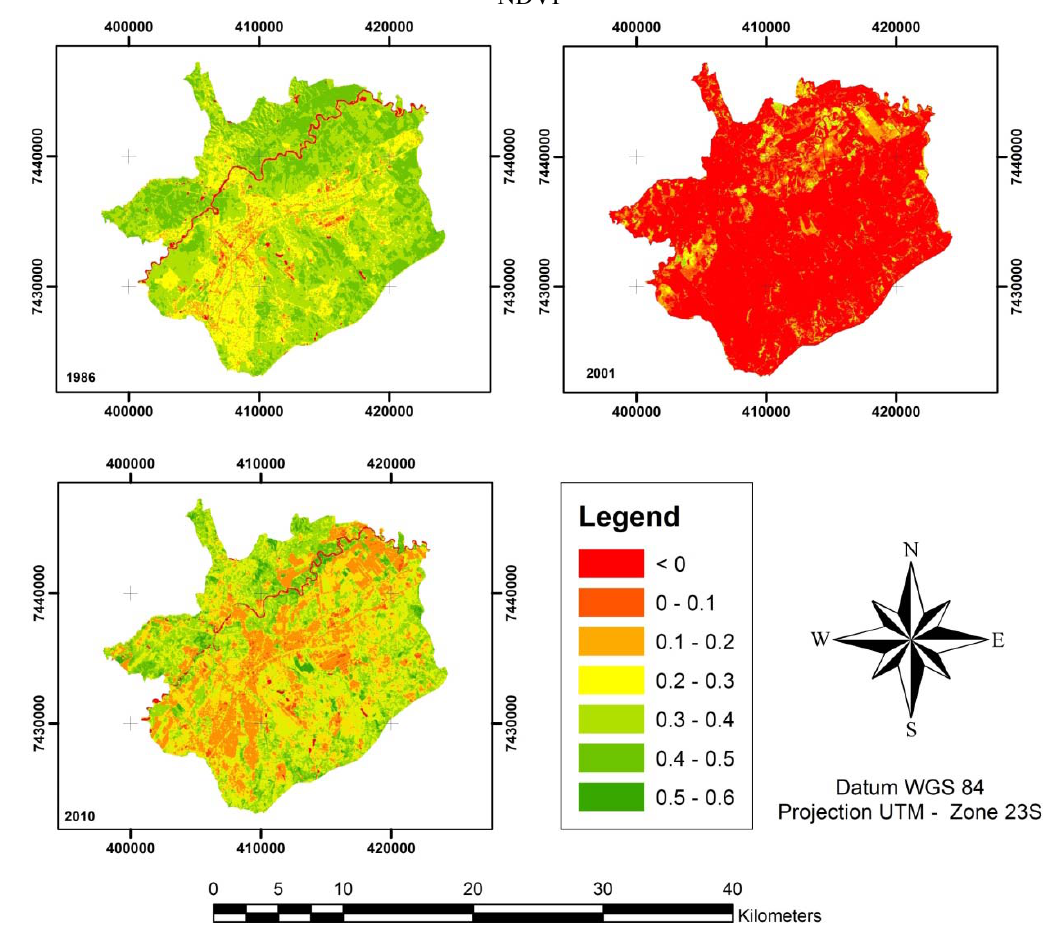
Figure 6. The NDVI calculated from the reflectance image of TM/Landsat 5 for 1986, 2001; and 2010.